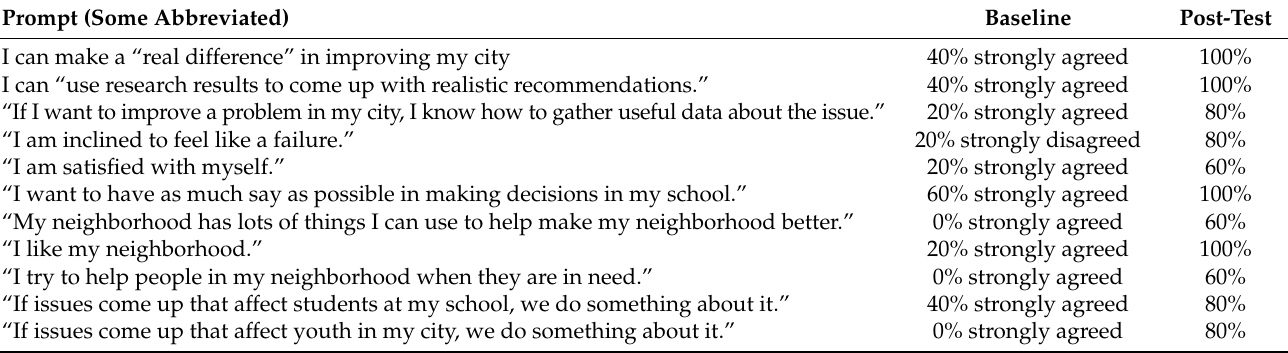
Table 2. Validated empowerment measures with strongest pre-post